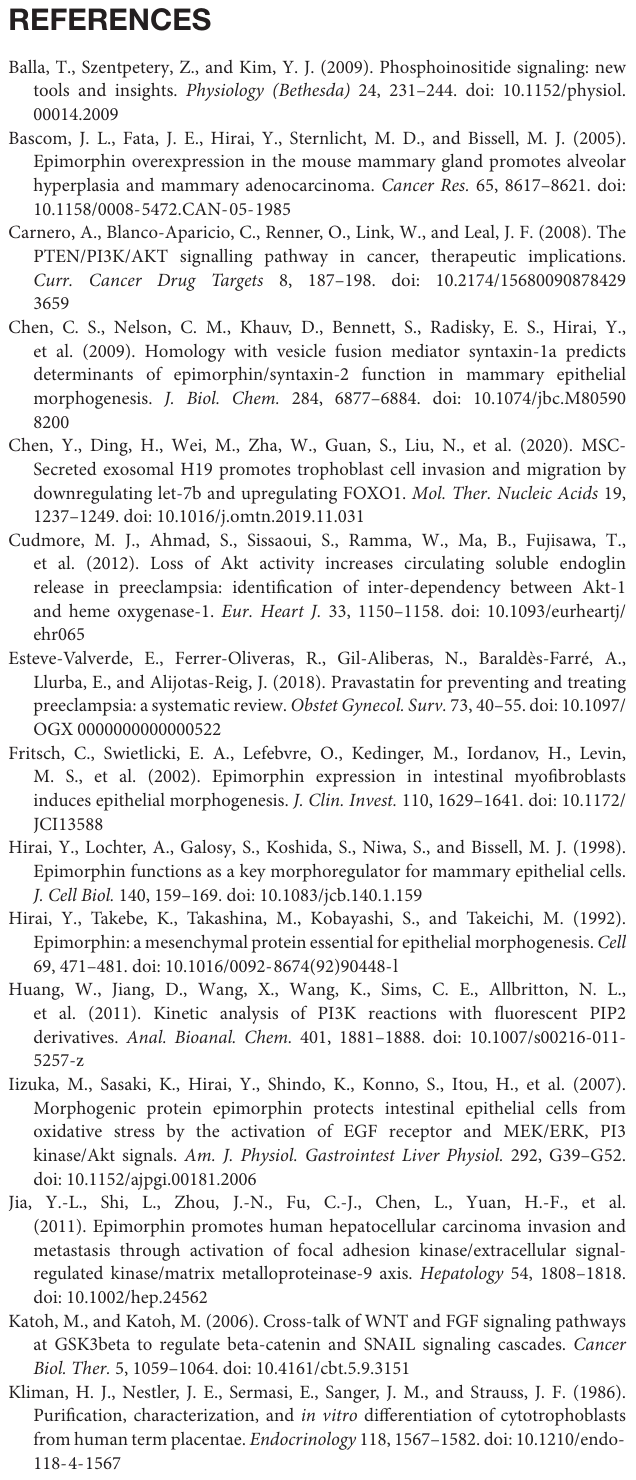
Supplementary Figure 1 | CCK-8 and Ki67 assays tested the trophoblast proliferation property in different treated groups. (A) CCK-8 assay of control and experimental cells in which STX2 was knocked down or overexpressed. (B) Ki67 cell proliferation assay of control and experimental cells in which STX2 was